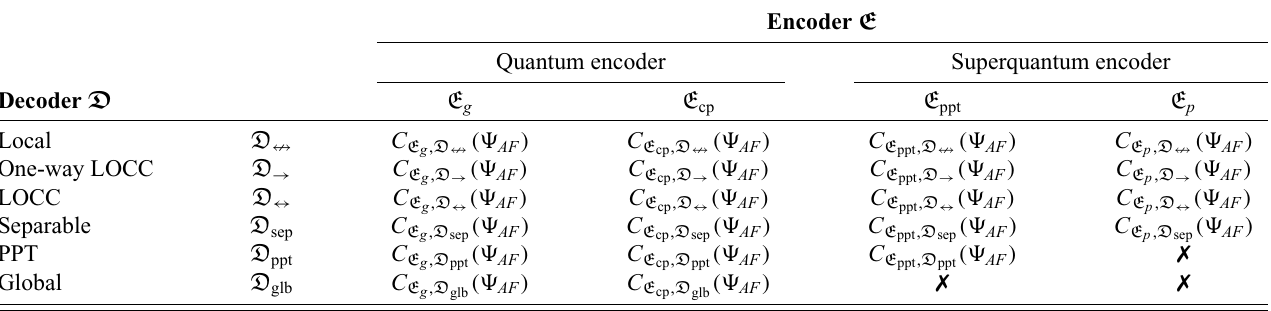
TABLE II. Landscape of the dense coding capacities investigated in this paper. We are able to show that the capacities in bold are actually equal and derive single-letter capacity formulas for all these capacities under Assumption 1. Encoder E Quantum encoder